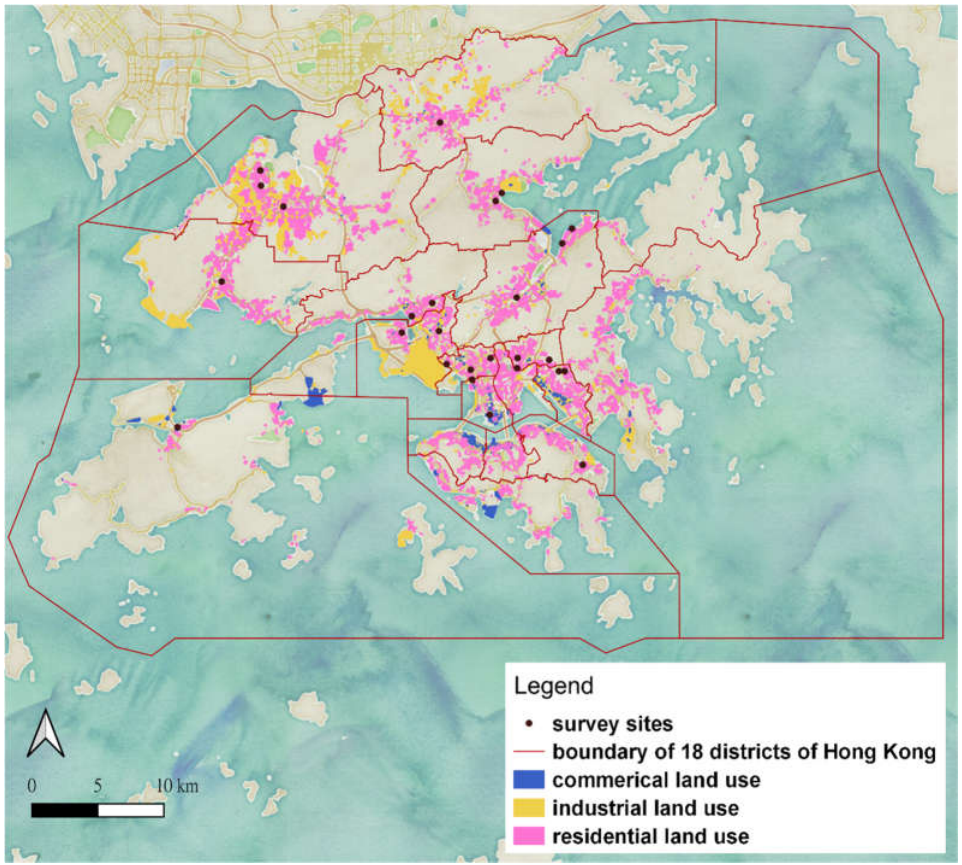
Figure 1. Map of Hong Kong indicating the locations of the 26 urban park sites where the questionnaire surveys were conducted in their vicinity. Map tiles by Stamen Design (stamen.com, accessed on 22 March 2022), under CC BY 3.0 (creativecommons.org, accessed on 22 March 2022). Map data